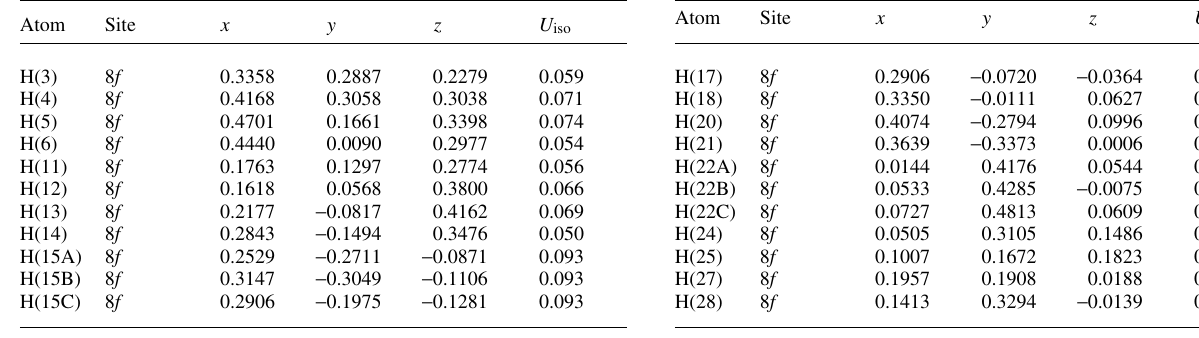
Table 2. Atomic coordinates and displacement parameters (in Å 2 )